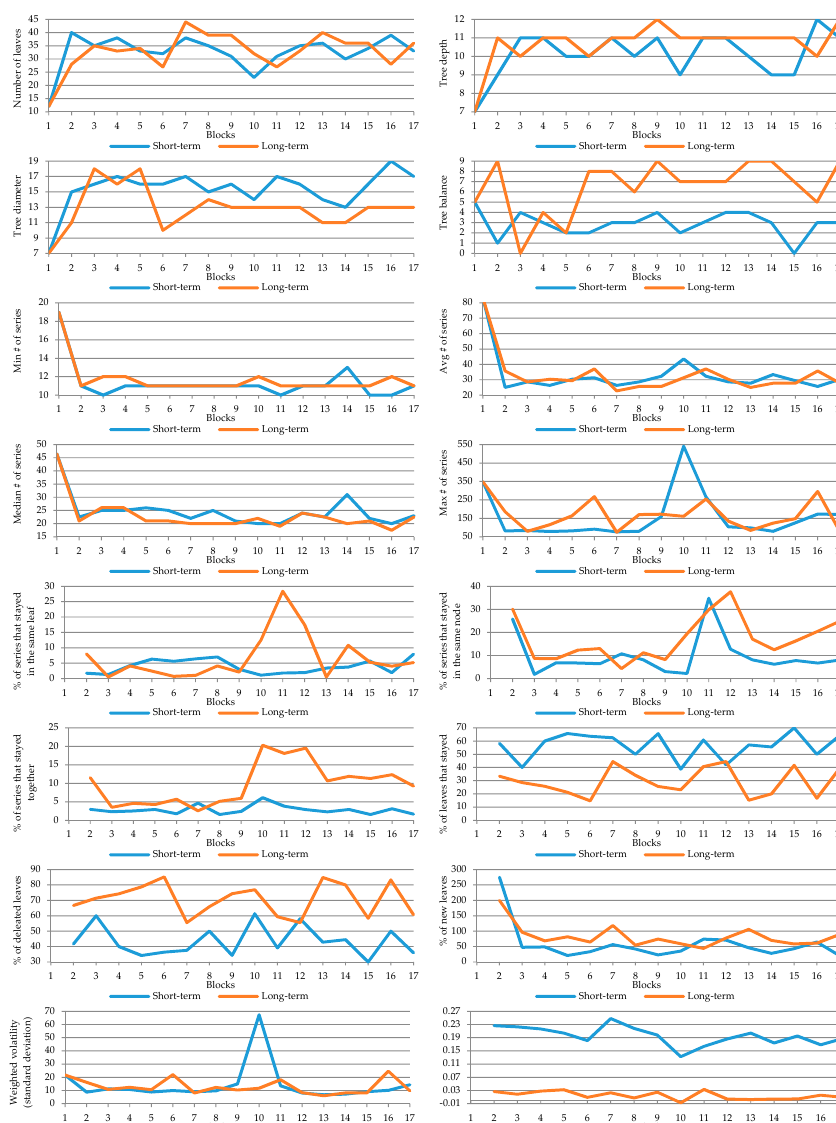
Figure A1. Detailed results for 𝑚𝑖𝑛𝑆𝑒𝑟𝑖𝑒𝑠 set at 1% and window length 𝑤 set at 30 days . Figure A2. Detailed results for 𝑚𝑖𝑛𝑆𝑒𝑟𝑖𝑒𝑠 set at 5% and window length 𝑤 set at 14 days .